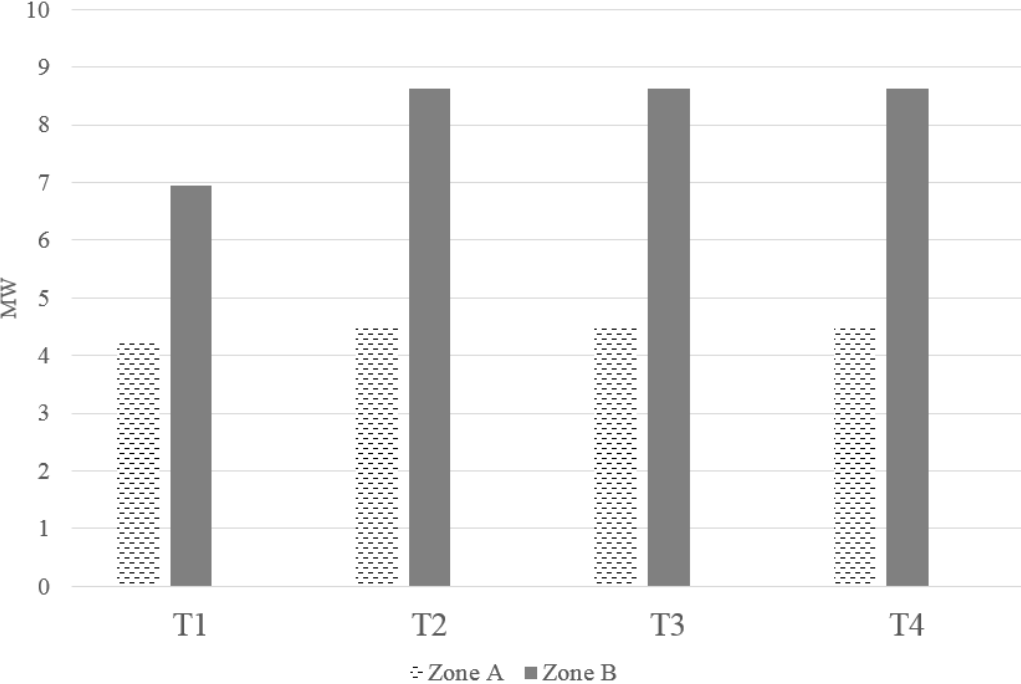
Figure 5. Discharging power of available EV fleets for an EV market penetration rate of 1%.